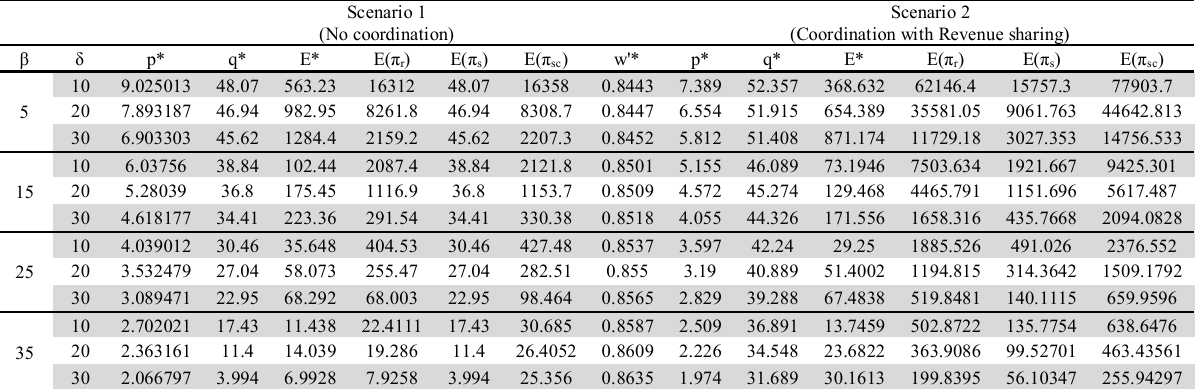
Optimal solutions of scenario 1 and Scenario 2